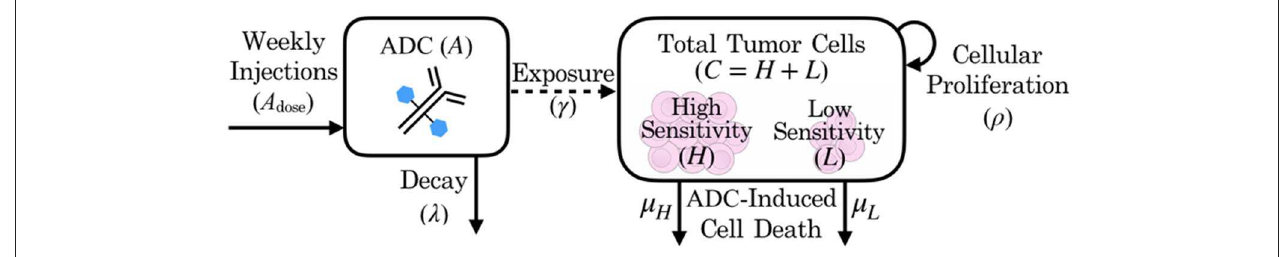
FIGURE 2 | Schematic of patient-derived xenograft response to an antibody drug conjugate, including key variables and parameters of the mathematical